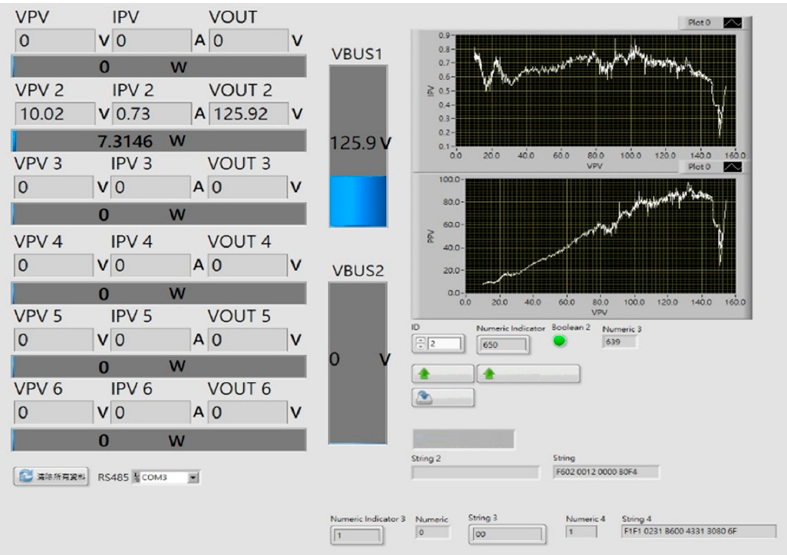
Figure 14. LabVIEW monitoring screen.